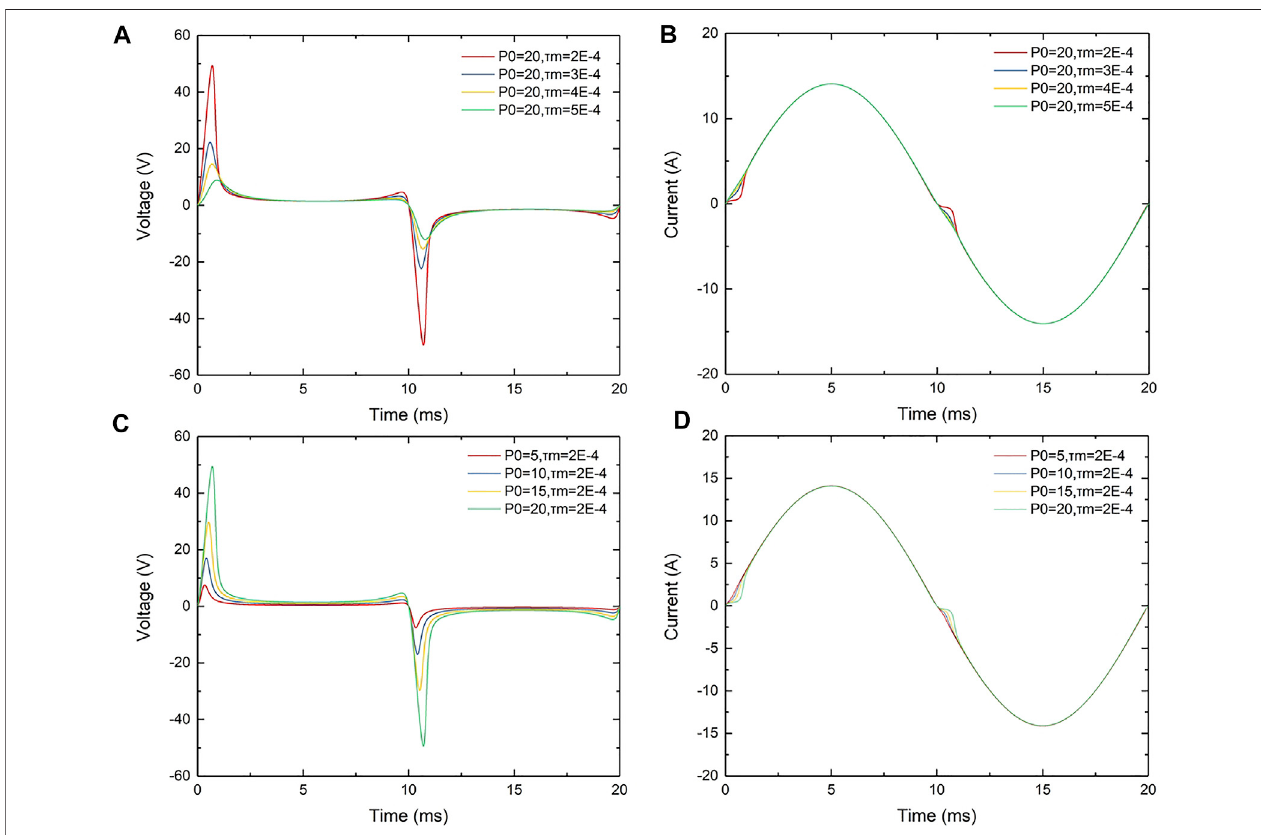
FIGURE2| EffectofMayrparameters. (A) Arcvoltageofdifferent τ m , (B) arccurrentofdifferent τ m , (C) arcvoltageofdifferent P 0 ,and (D) arccurrentofdifferent P 0 .